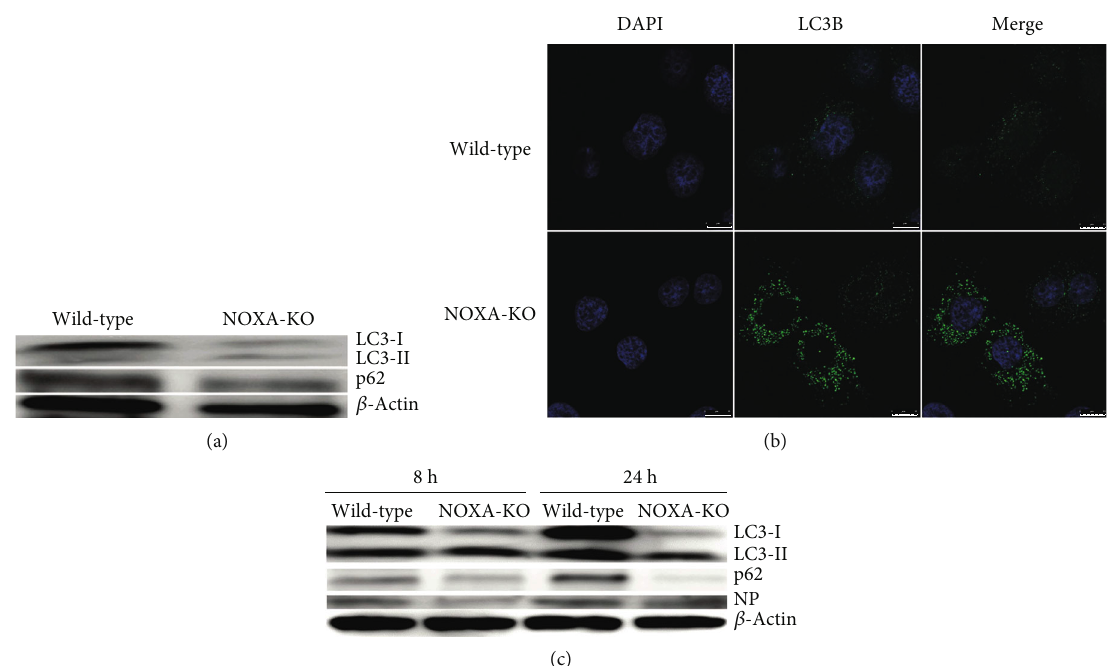
Figure 3: Loss of Noxa increases LC3 accumulation and reduces p62 expression. (a) Immunoblot analysis of LC3 and p62 expression in wild-type and Noxa-de fi cient A549 cells. β -Actin was used as the loading control. (b) Wild-type and Noxa-de fi cient A549 cells were transfected with a plasmid encoding GFP-LC3 for 24h and then fi xed and stained with DAPI (blue). Scale bars, 10 μ m. (c) Immunoblot analysis of LC3 and p62 expression in wild-type and Noxa-de fi cient A549 cells 8h and 24h postinfection. β -Actin was used as the loading